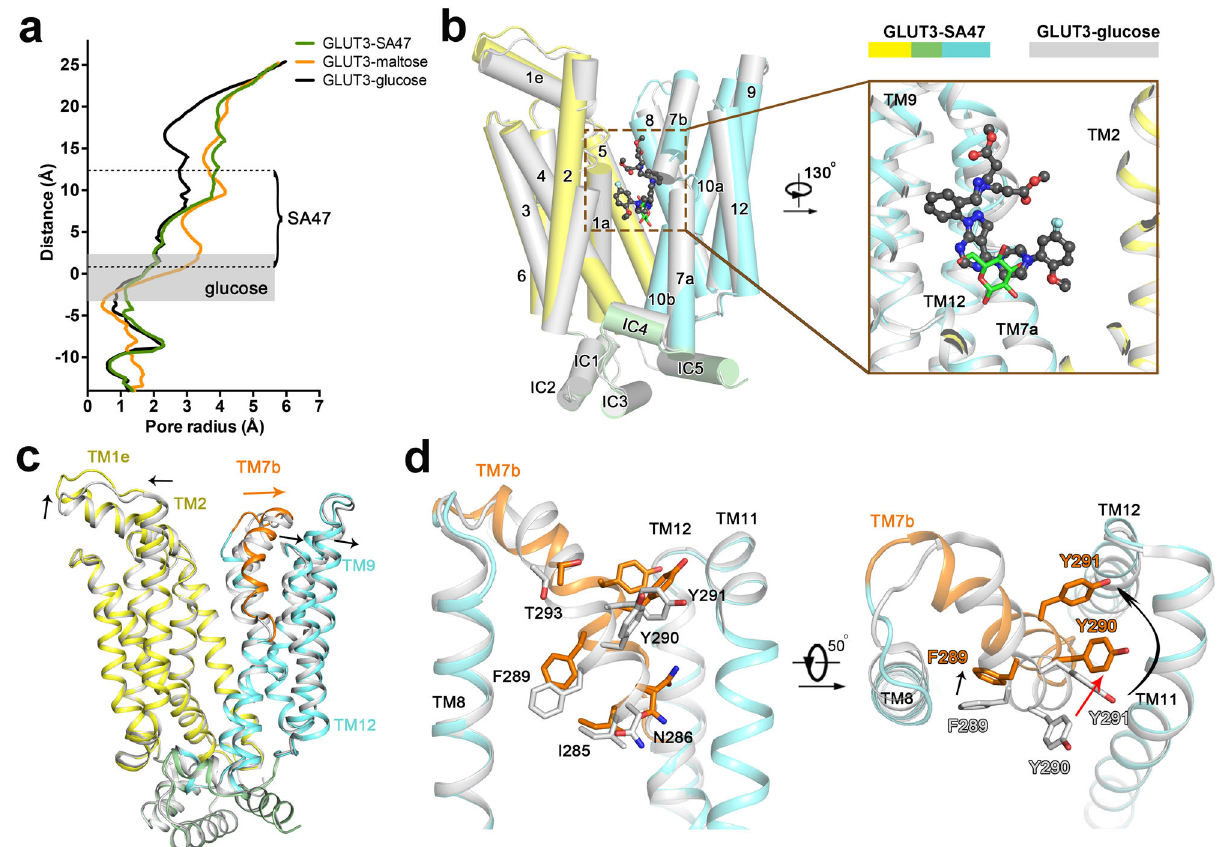
Fig. 3 Structural comparison of GLUT3-SA47 and GLUT3-glucose complexes. a The structure of GLUT3-SA47 exhibits a similar outward-open state as that of maltose-bound GLUT3. The radii of extracellular substrate access tunnel in the indicated GLUT3 structures were calculated in HOLE 34 . The glucose- binding site in GLUT3-glucose complex is indicated by the gray shade. b Partial overlap between SA47 and glucose in GLUT3. TM11 is omitted for a clear view of ligands. SA47 and glucose are shown as black ball-and-sticks and green sticks, respectively. c Local conformational shifts between GLUT3-SA47 and GLUT3-glucose. The arrows indicate the TM movements that widen the path to the central pocket. TM11 is omitted for a clear view of the movement of TM7b, which is colored in GLUT3-SA47. d Structural shift of TM7b residues upon SA47 binding. The corresponding TM7b residues in GLUT3-SA47 and GLUT3-glucose are colored orange and gray,